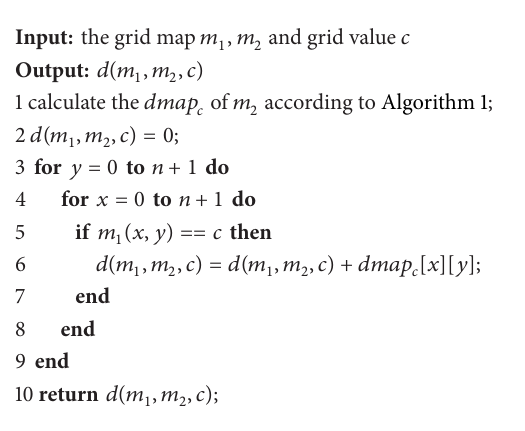
Algorithm 2: Calculation process of 𝑑(𝑚 1 ,𝑚 2 , 𝑐)